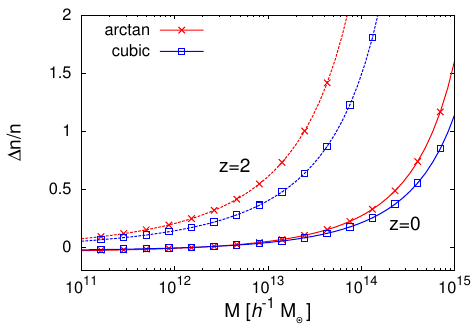
Figure 8. Fractional increase in halo abundance in K-mouflage relative to Λ CDM as a function of halo mass. Results are shown for two different redshifts and K-mouflage models. Reproduced from